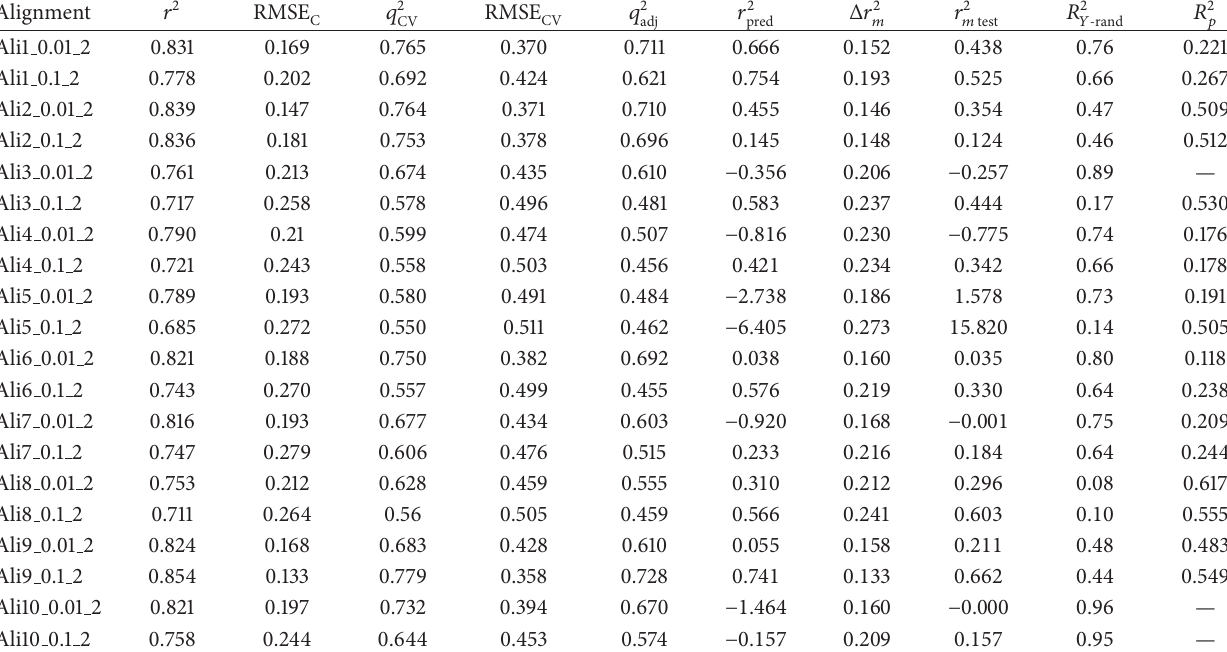
Table 2: Summary of results of the best 4D-QSAR models obtained for the ten alignments with Test Group II and their respective cuts.